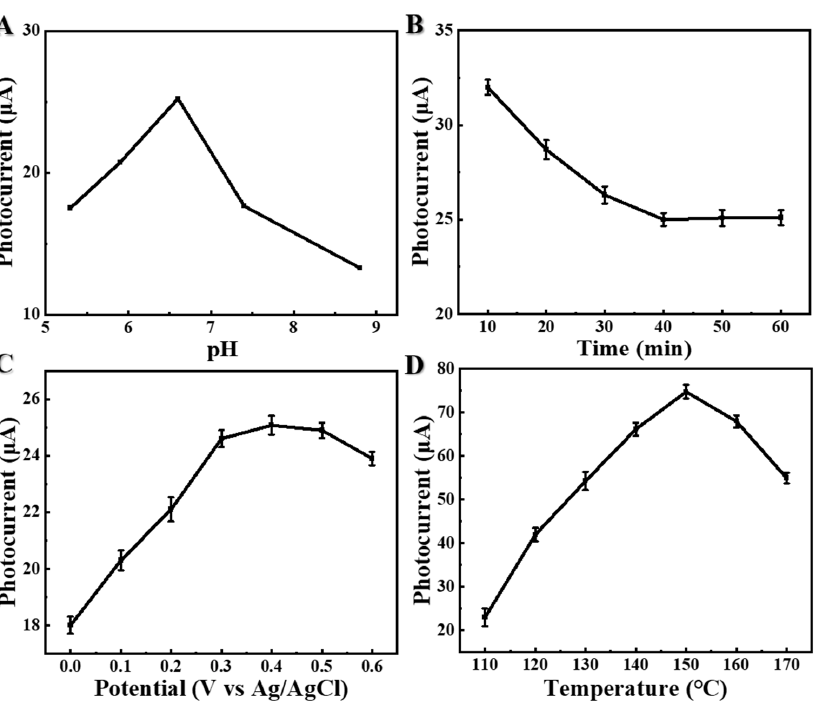
Figure 5. Effect of ( A ) the pH of PBS on photocurrent responses of the paper-based biosensor ( c AFP = 0.1 ng mL − 1 ). ( B ) The incubation time of AFP ( c AFP = 0.1 ng mL − 1 ). ( C ) The potential of PEC measurement ( c AFP = 0.1 ng mL − 1 ). ( D ) The photocurrent of different synthesis temperature of ZnIn 2 S 4 nanoflakes.